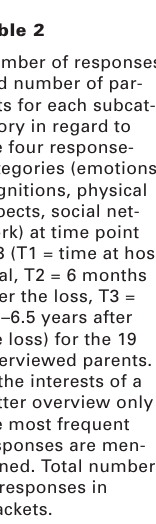
Table 2 Number of responses and number of par- ents for each subcat- egory in regard to the four response- categories (emotions, cognitions, physical aspects, social net- work) at time point 1–3 (T1 = time at hos- pital, T2 = 6 months after the loss, T3 = 3.5–6.5 years after the loss) for the 19 interviewed parents. In the interests of a better overview only the most frequent responses are men- tioned. Total number of responses in